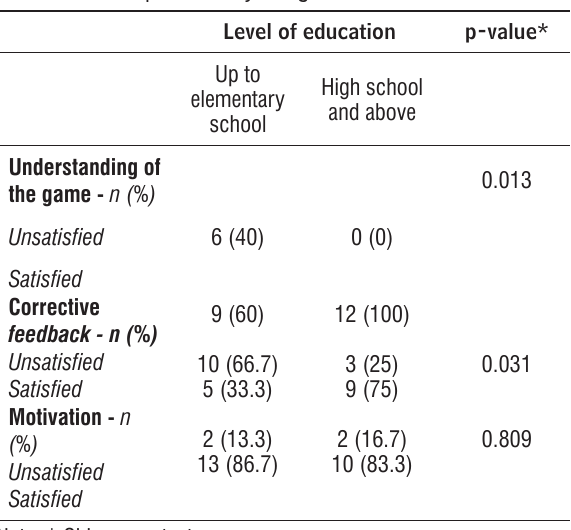
Table 2 - Degree of satisfaction associated to the level